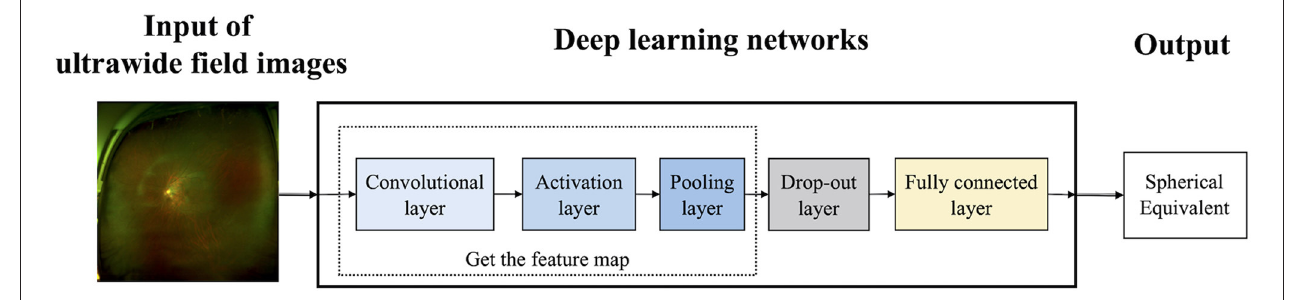
FIGURE 1 | The training process of deep learning